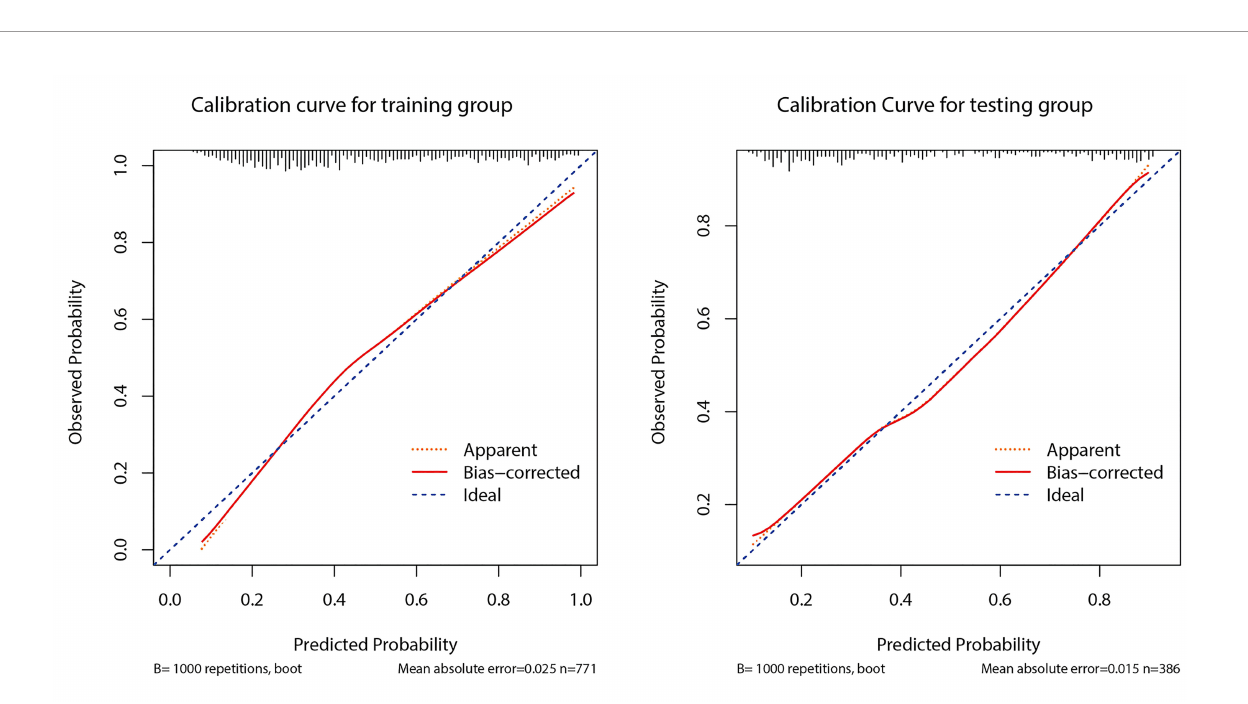
FIGURE 5 | Calibration curves of the prediction model 1 in the development and validation